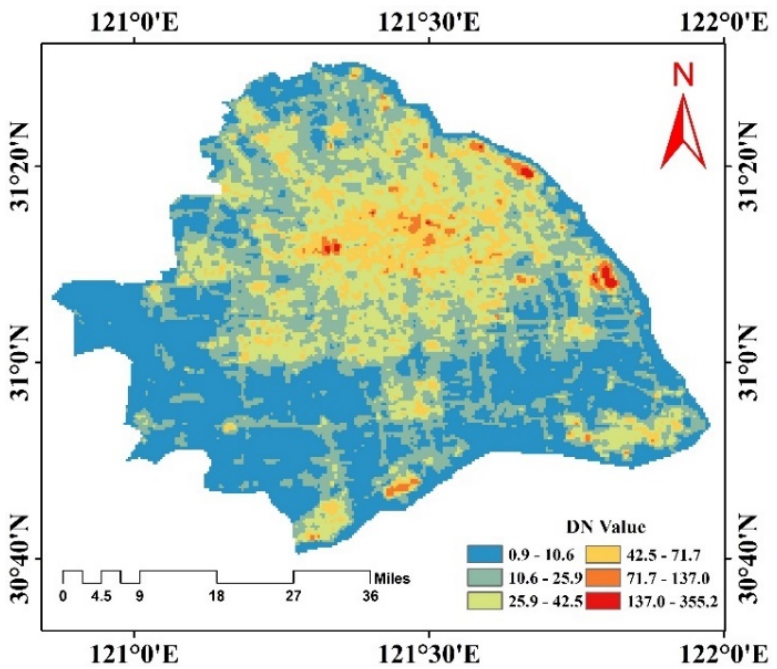
Figure 17. Night lighting data of main urban area of Shanghai in Shanghai in April 2020.